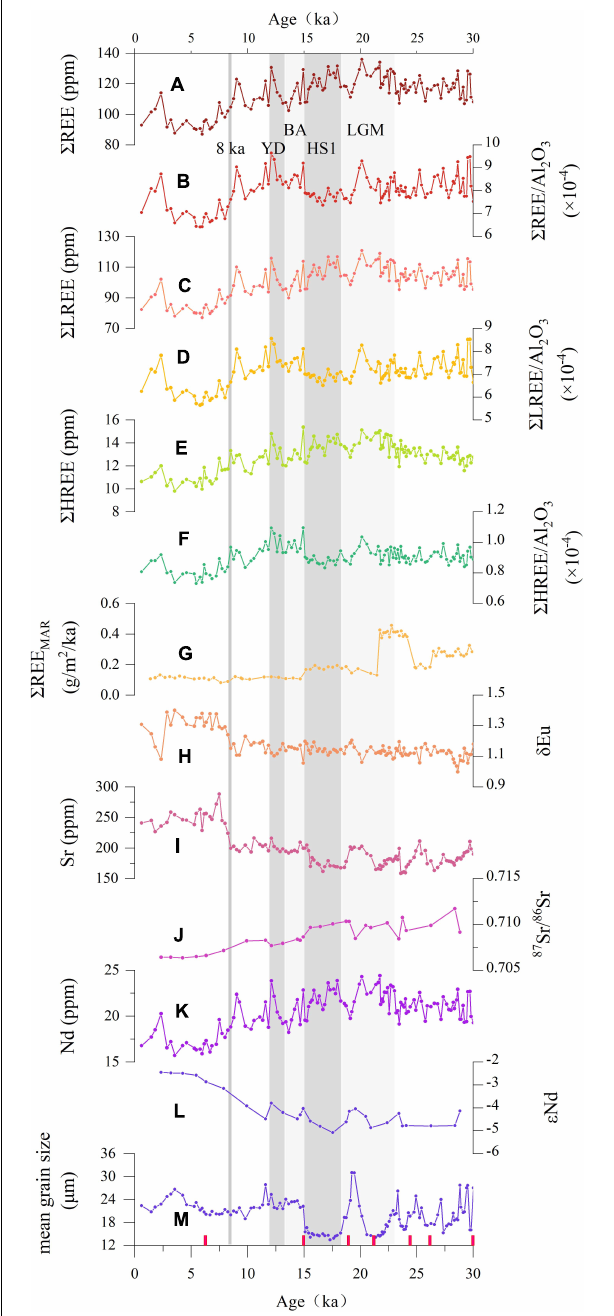
FIGURE 4 | Depth profiles of parameters of REEs (A–H) , Sr-Nd (I–L) , and grain size (M) in core LV53-18-2. Red rectangles denote age control points.